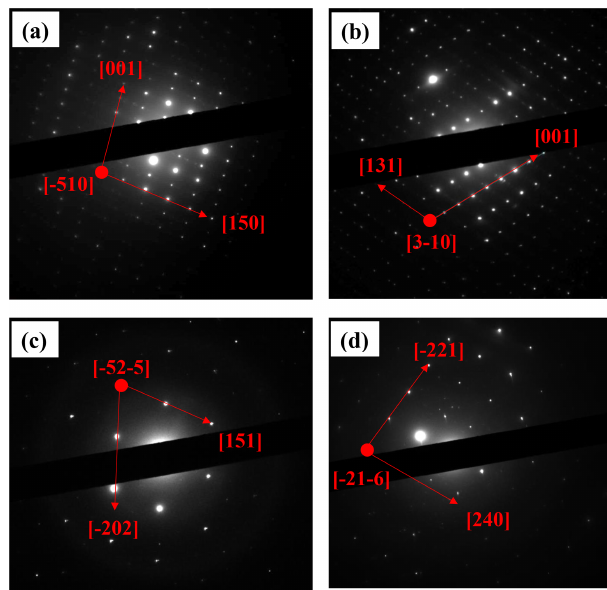
Figure 10. (a–d) SAED patterns collected using the JEOL 2010 TEM on different glaucophane crystals showing different orienta- tions, crystallographic directions (red arrows), and lattice defects (streaking in panels a and b ). The zone axes are indicated by the red dots.